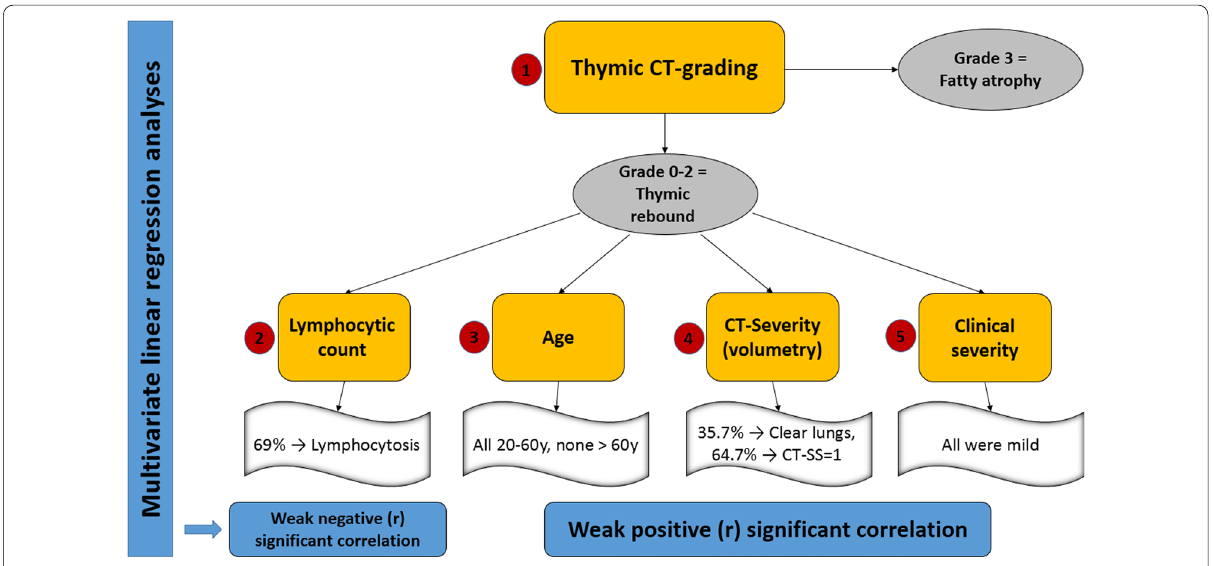
Fig. 10 A graph is summarizing the results of this multivariate linear regression analyses